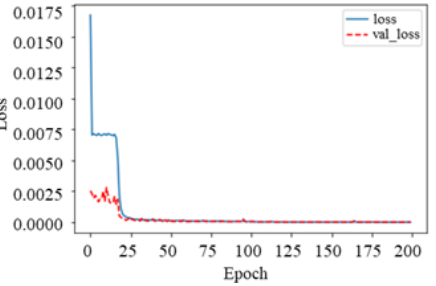
Figure 7. Loss for training data and validation data in Case 1.